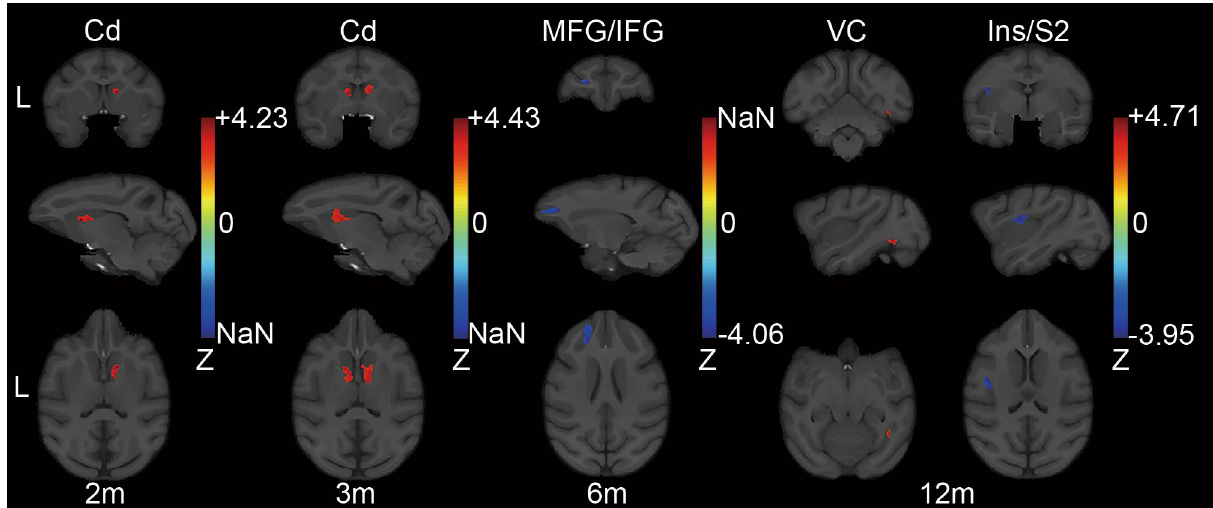
Figure 1. GMV differences between LC and NT3 animals overlaid on the T1 template image. Only clusters with significant differences were displayed (two-sample t-test with GRF correction). The voxel level was set to p < 0.005, and the cluster level was set to p < 0.05. The brain regions where the significant clusters were located were presented above the images; m represented the month; a positive value in the Z-bar indicated that LC > NT3; L indicated the left side; Cd caudate nucleus, MFG middle frontal gyrus, IFG inferior frontal gyrus, VC visual cortex, Ins insula, S2 secondary somatosensory